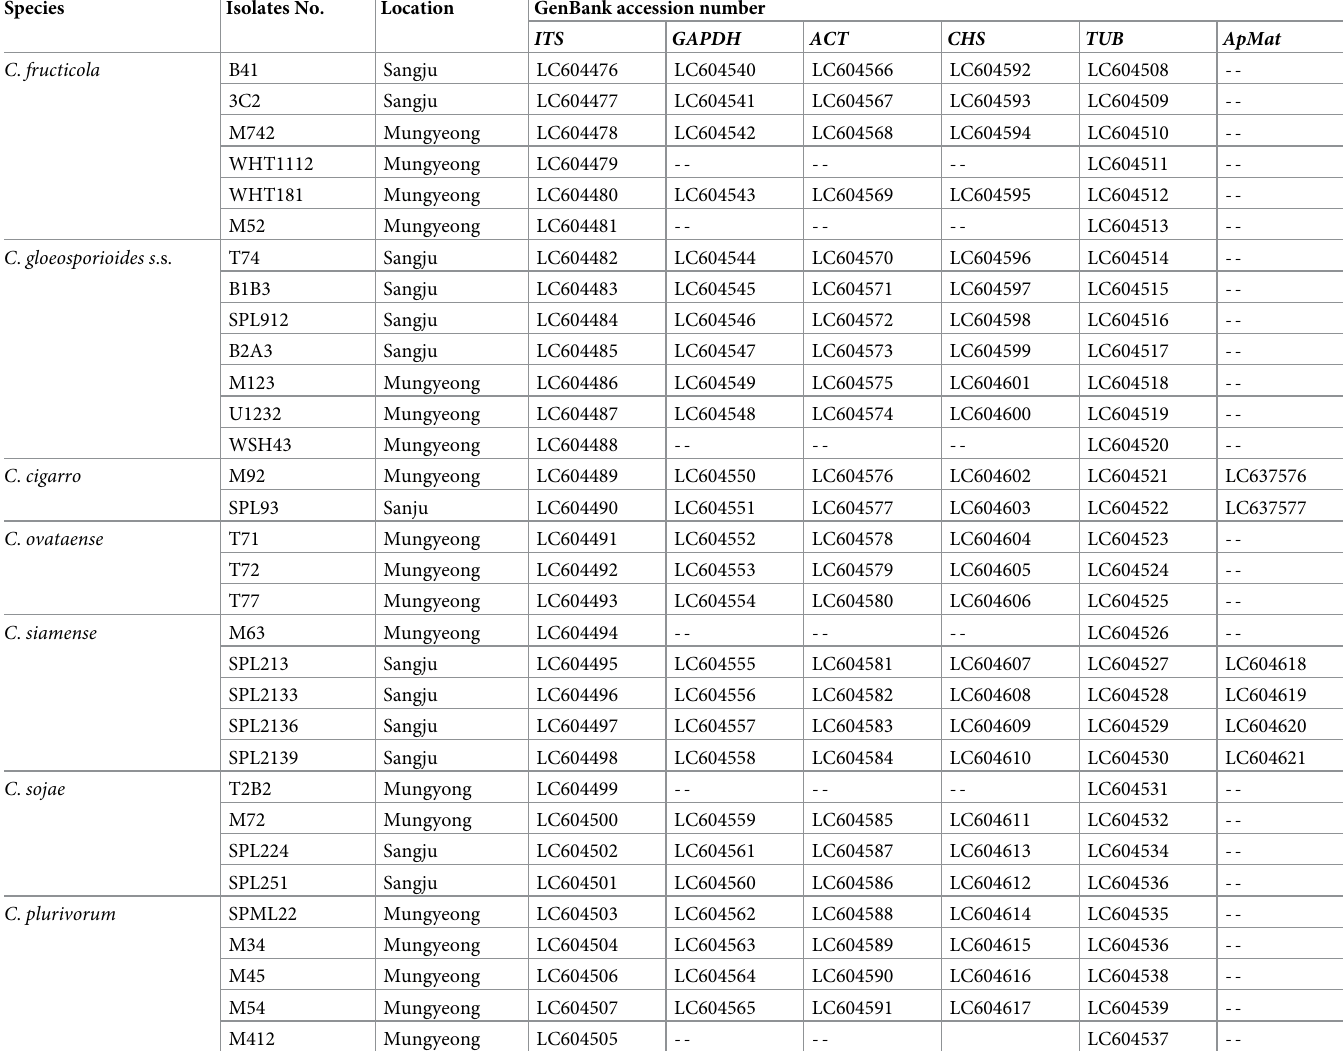
Table 1. List of 32 representative isolates of seven Colletotrichum spp. collected from leaf spot of OLA in South Korea, with collection details and GenBank acces- sion numbers. Species Isolates